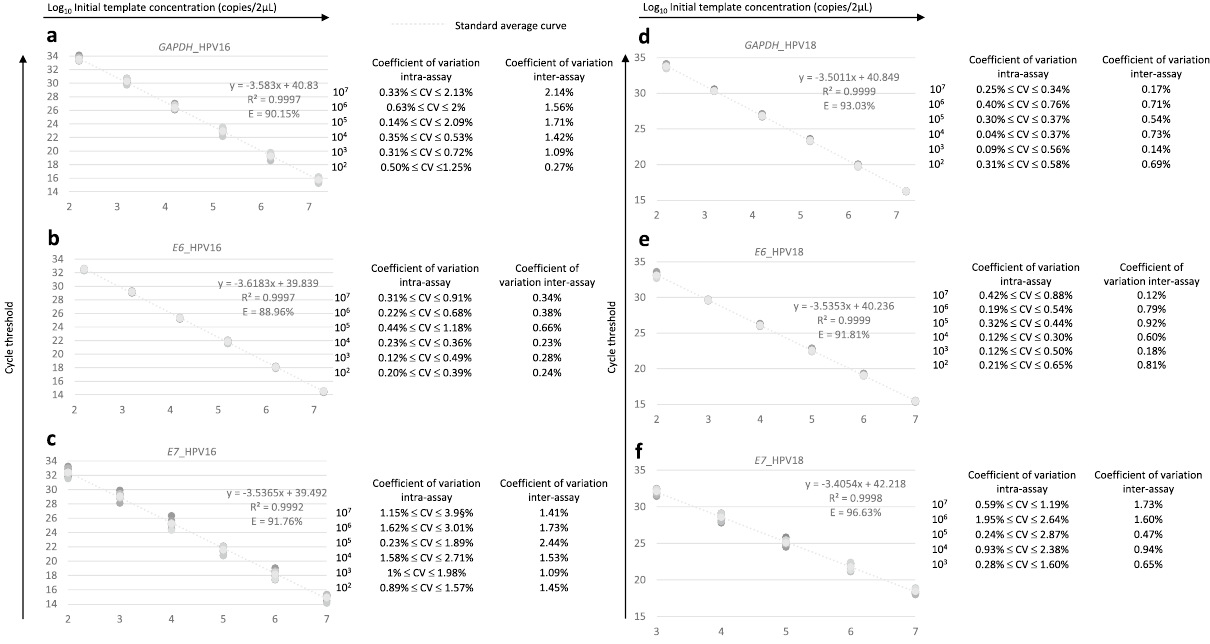
Figure 2. Sensibility and linearity of HPV16 and HPV18 triplexes. Standard curves were generated by amplification of serial dilutions from 10 7 to 10 –2 of E6 , E7 and GAPDH plasmid pool for HPV16 ( a – c ) and HPV18 ( d – f ) using multiplex qPCR. Each dilution was run in biological and technical triplicate. R 2 represent the coefficient of determination and the PCR efficiency (E) of each target was calculated using the slope of each standard curve with the formula E = (10 –1/slope − 1)*100.